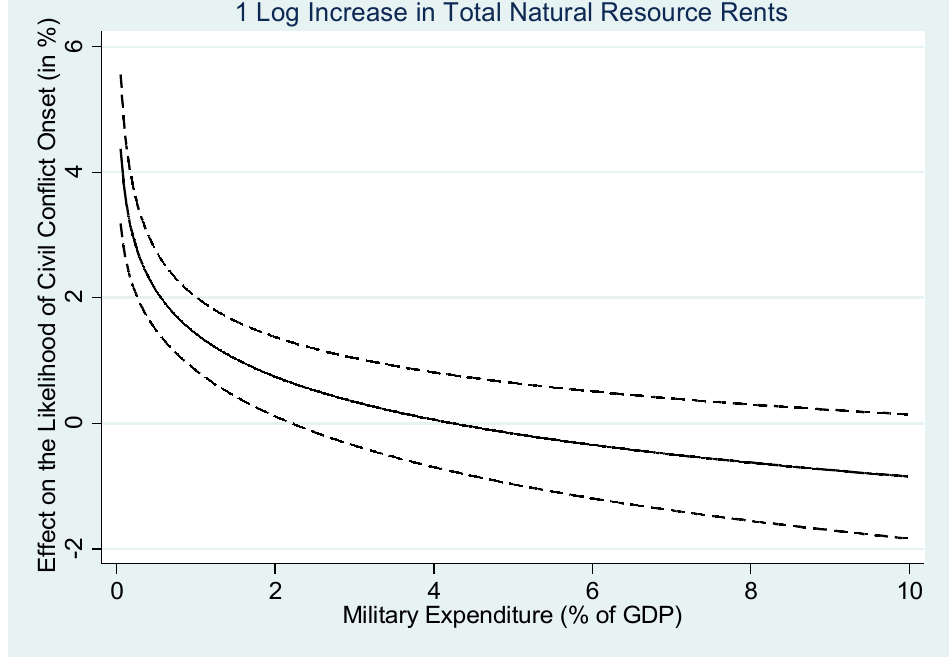
Figure 1. Natural Resource Rents and the Risk of Civil Conflict Onset: The Role of Military Expenditures. The figure plots the effect of a 1 log increase in the GDP share of natural resource rents on the likelihood (in %) of civil conflict onset. Dashed lines are 95 percent confidence bands. The figure is generated from the estimated logit model in column (1) of Table 2.